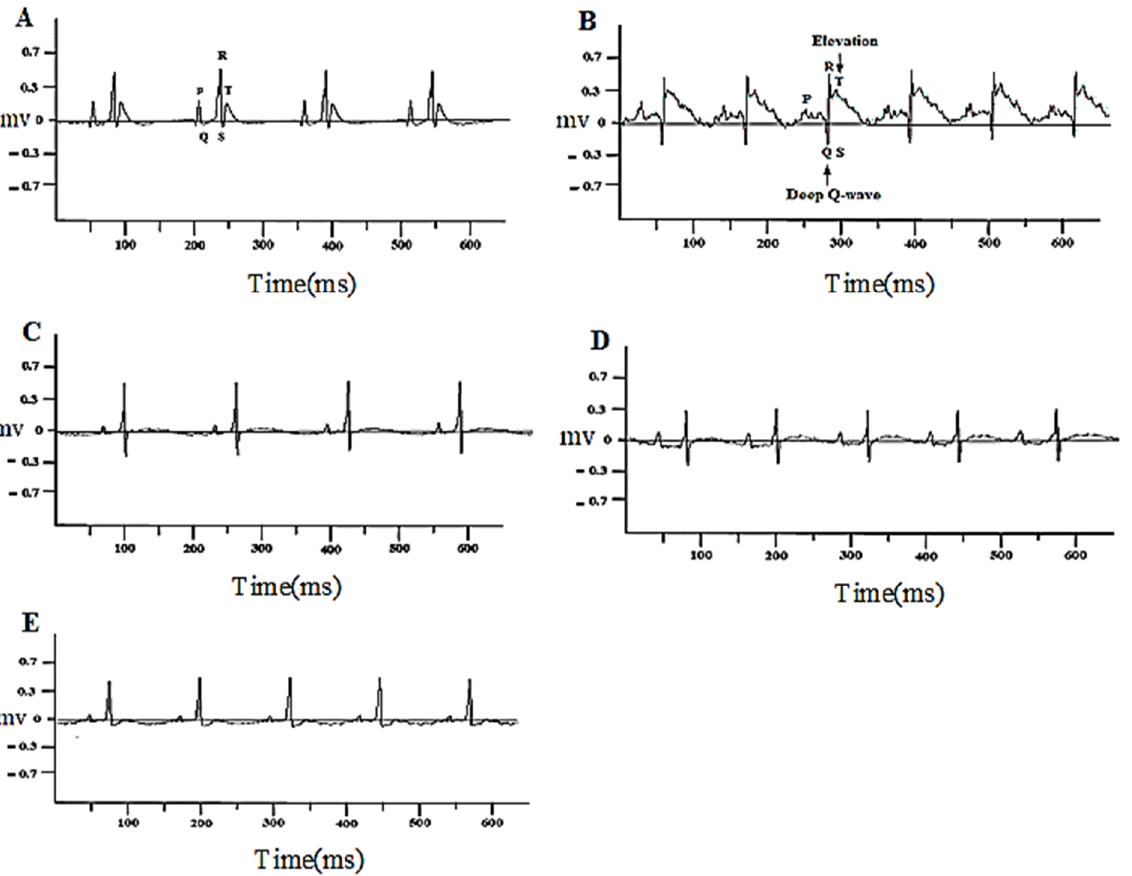
Figure 2. Representative lead II electrocardiogram (ECG) tracings of ( A ) control, ( B ) ISO-alone, ( C ) atenolol (1 mg/kg) + ISO, ( D ) bergenin, 1 mg + ISO, and ( E ) 3 mg/kg + ISO treated rats, respectively (recording speed 50 ms/div). Millisecond (ms), division (div), millivolt (mv).